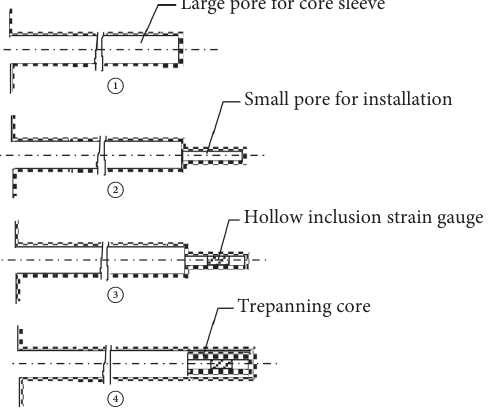
Figure 2: Trepanning stress relief method